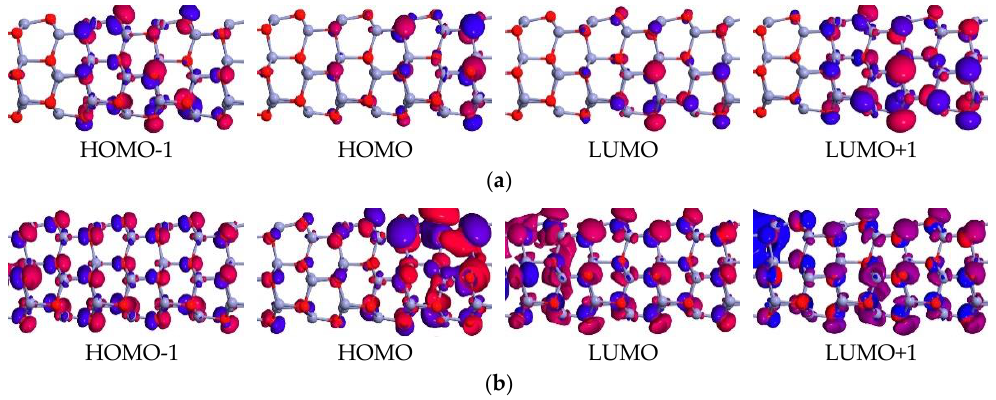
Figure 7. Spatial distribution of molecular-projected self-consistent Hamiltonian (MPSH) states of 6-ZnONR, ( a ) 0.8 V, ( b ) 1.6 V, and the zero of the energy is set to Fermi level.